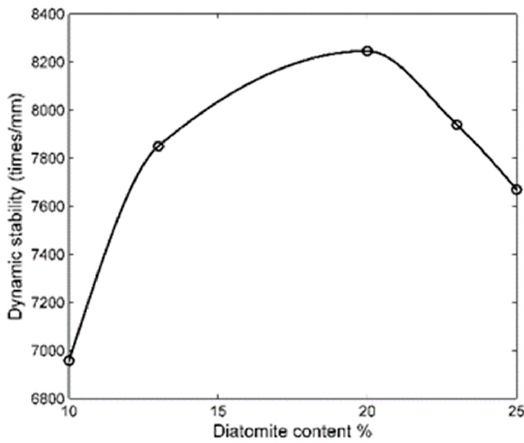
Figure 3. Rutting test results of diatomite with different content.